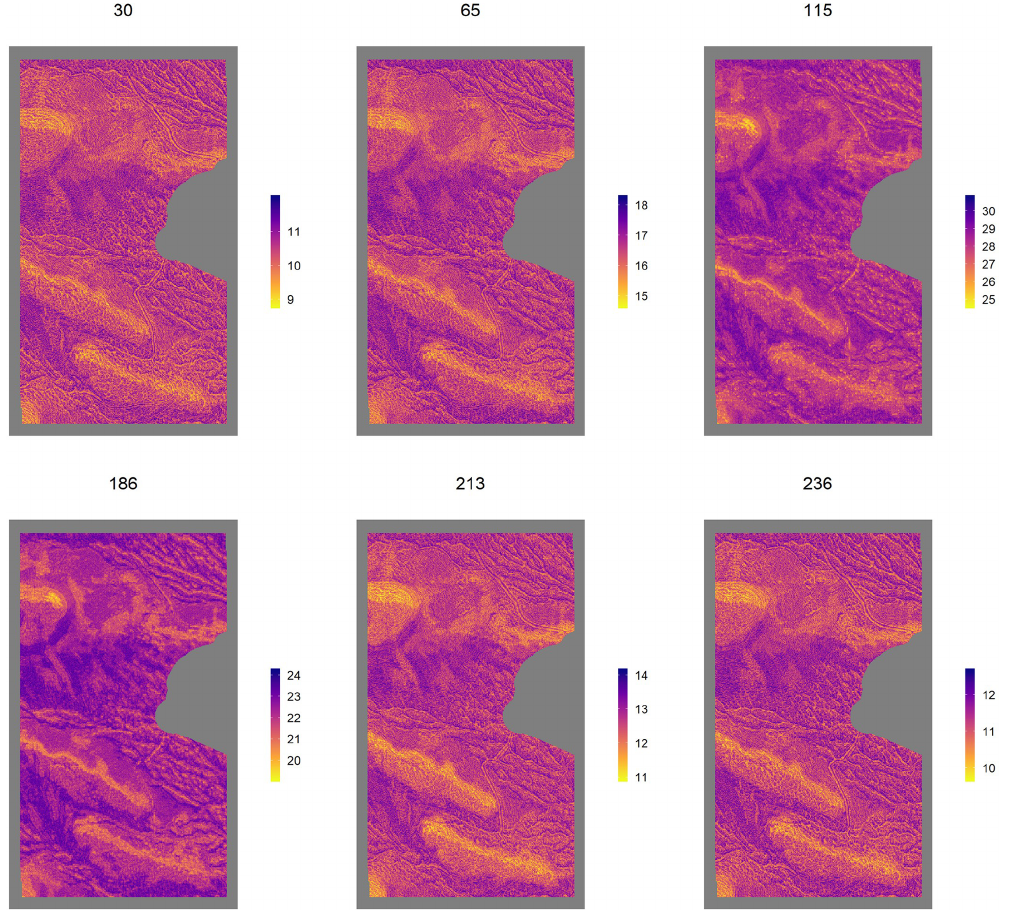
Figure 10. Predicted soil moisture content (percent) over the study area for the 6d sampled. Days of the water year 30, 65, 115, 186, 213,